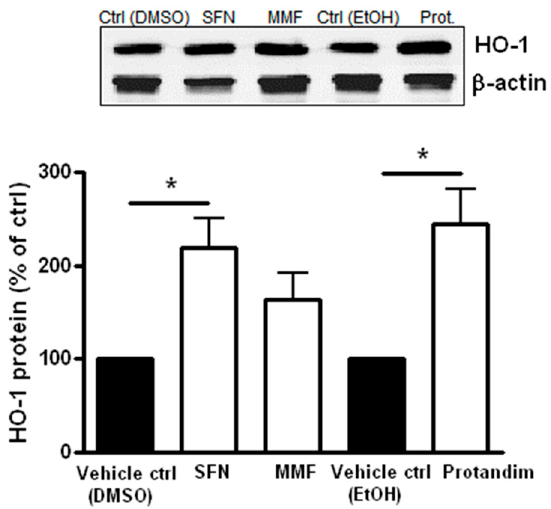
Figure 6. Nrf2-activators dose-dependently increase HO-1 protein expression in primary rat OPCs. After 2 day de-differentiation of OLs with growth factors bFGF-2 and PDGF-AA, primary rat OPCs were treated with 5 µ M SFN, 90 µ M MMF,30 µ g/mL Protandim or their respective DMSO or EtOH vehicle control for 24 h. Protein levels were assayed by Western blotting. Data are presented as percentage of control and expressed as the mean ± SEM of 3 independent experiments. Statistics reflect one-way ANOVA test with post hoc Bonferroni correction; * p <